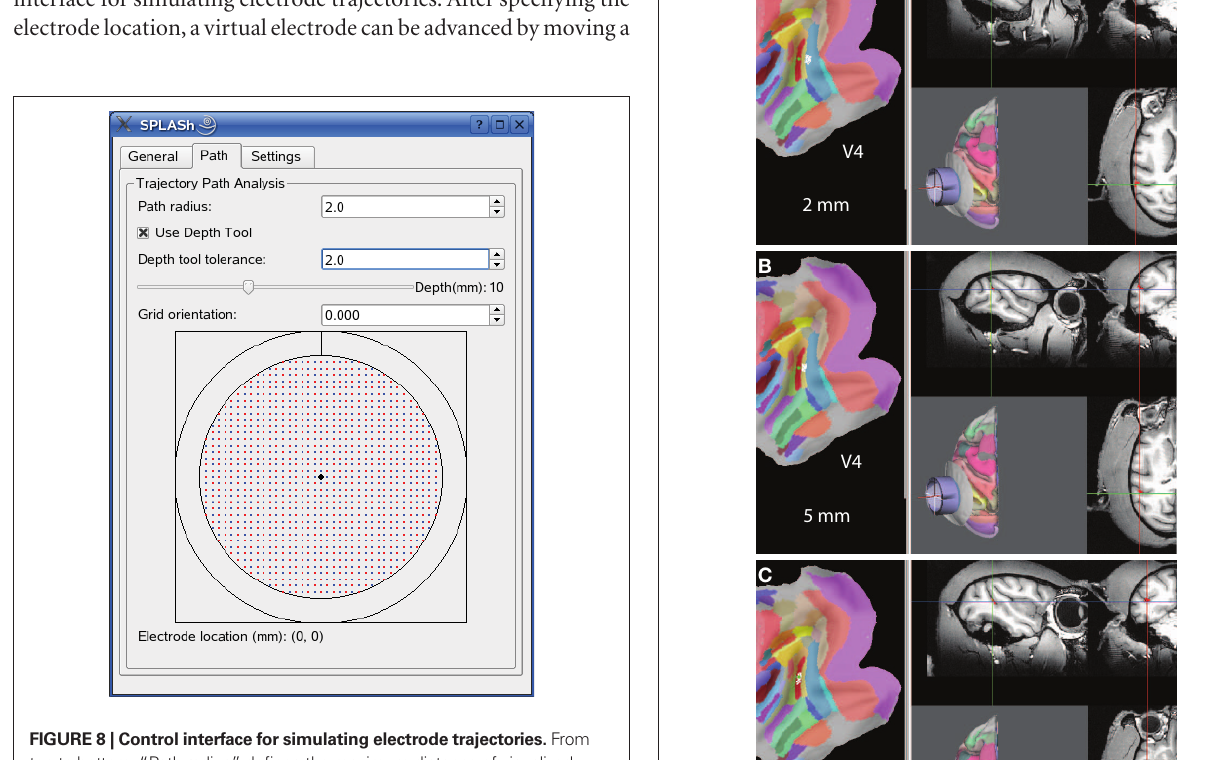
Figure 8 | Control interface for simulating electrode trajectories. From top to bottom: “Path radius” defines the maximum distance of visualized nodes from the virtual electrode. “Use Depth Tool” visualizes only nodes near the “tip” of the virtual electrode by constraining the depth. Only nodes whose depth does not deviate more than “Depth tool tolerance” are marked. Depth is measured along the virtual electrode track with zero depth being defined as the intersection of the electrode track with the outer brain surface. The virtual electrode is advanced by moving the slider below “Depth tool tolerance.” The current depth is indicated to the right of the slider and the search results are updated in real-time. “Grid orientation” allows specifying electrode locations relative to the center of the recording chamber in a coordinate system that is rotated with respect to the default coordinate system (see Materials and Methods). The electrode location is specified by clicking on one of the red and blue grid points.